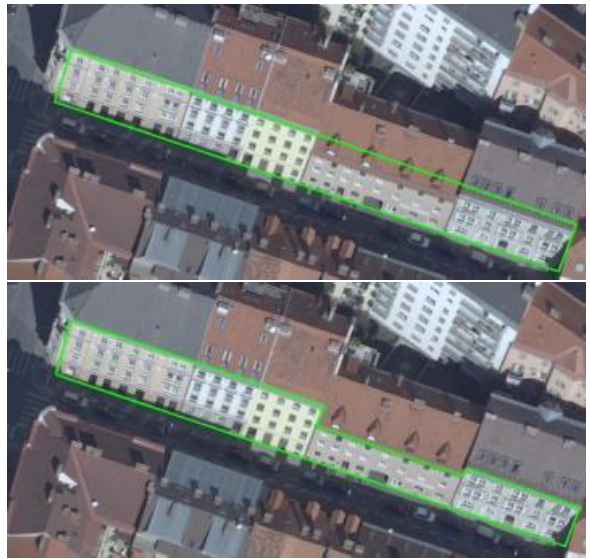
Figure 6. (Top) Projected façade quadrilaterals (Bottom) projected façade polygon